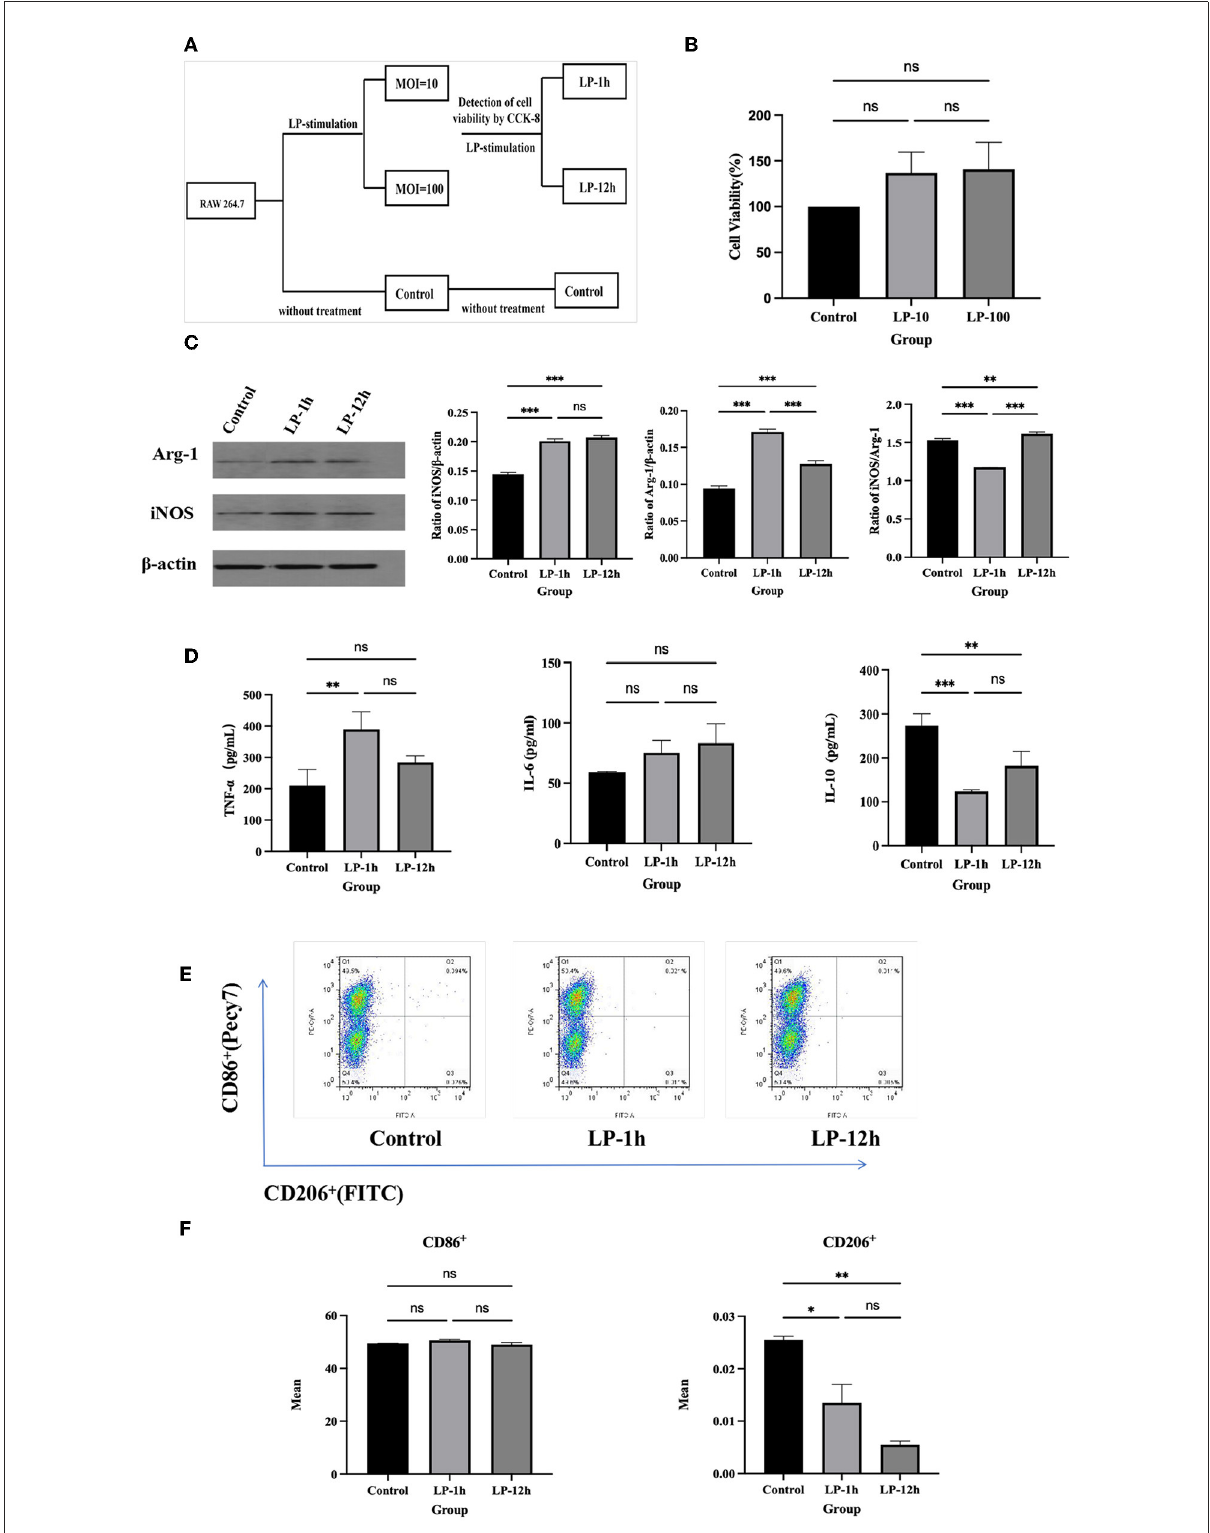
FIGURE1 The effect of RAW 264.7 polarization induced by LP. RAW 264.7 (5 × 10 4 cells/well) was inoculated into a 96-well plate and exposed to LP (5 × 10 5 or 5 × 10 6 CFU/well) at an MOI of 10 or 100 for 12h. CCK-8 assay was performed to evaluate the safety of LP. RAW 264.7 (5 × 10 4